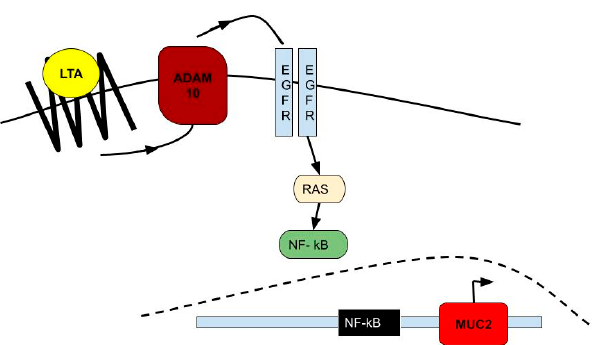
Figure 3. LTA from Gram-positive bacteria induces increased mucus production via the PAFR which activates the ADAM10 pathway leading to mucin 2 (MUC2) transcription via NF-